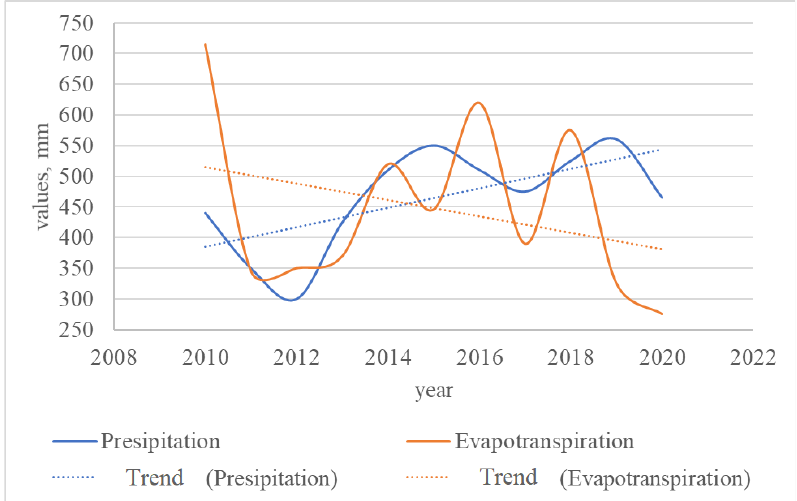
Figure 5. Average annual values showing the relationship between evapotranspiration and precipitation in the downy oak forest in the period 2010 – 2020.